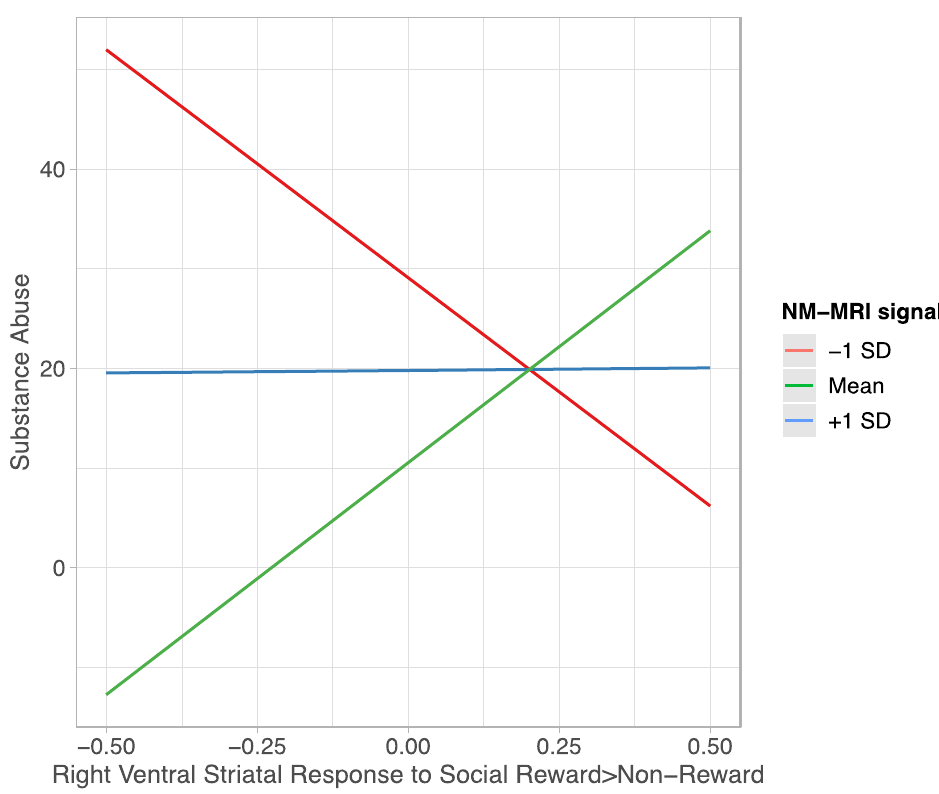
Figure 3. Depiction of moderating effect of NM-MRI signal on the relation between right ventral striatal response to social reward (vs. non-reward) and substance abuse. SD = standard deviation.